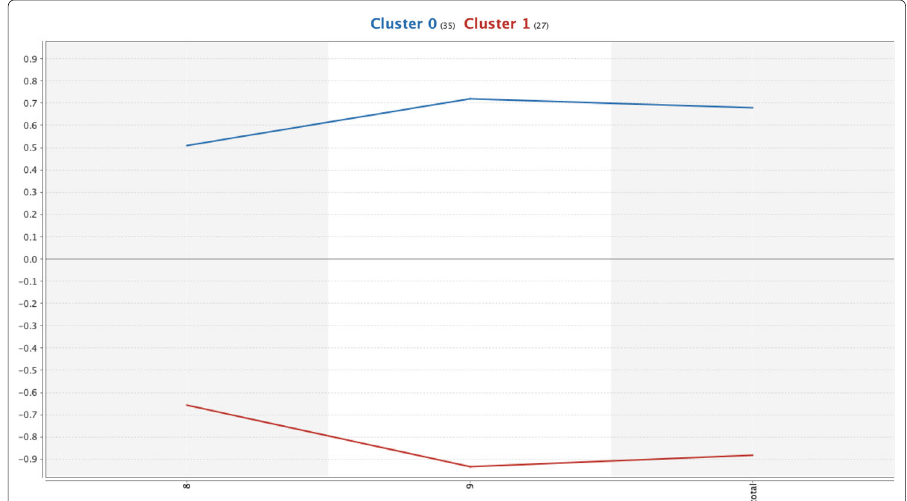
Fig. 1 Centroid chart of k -means in